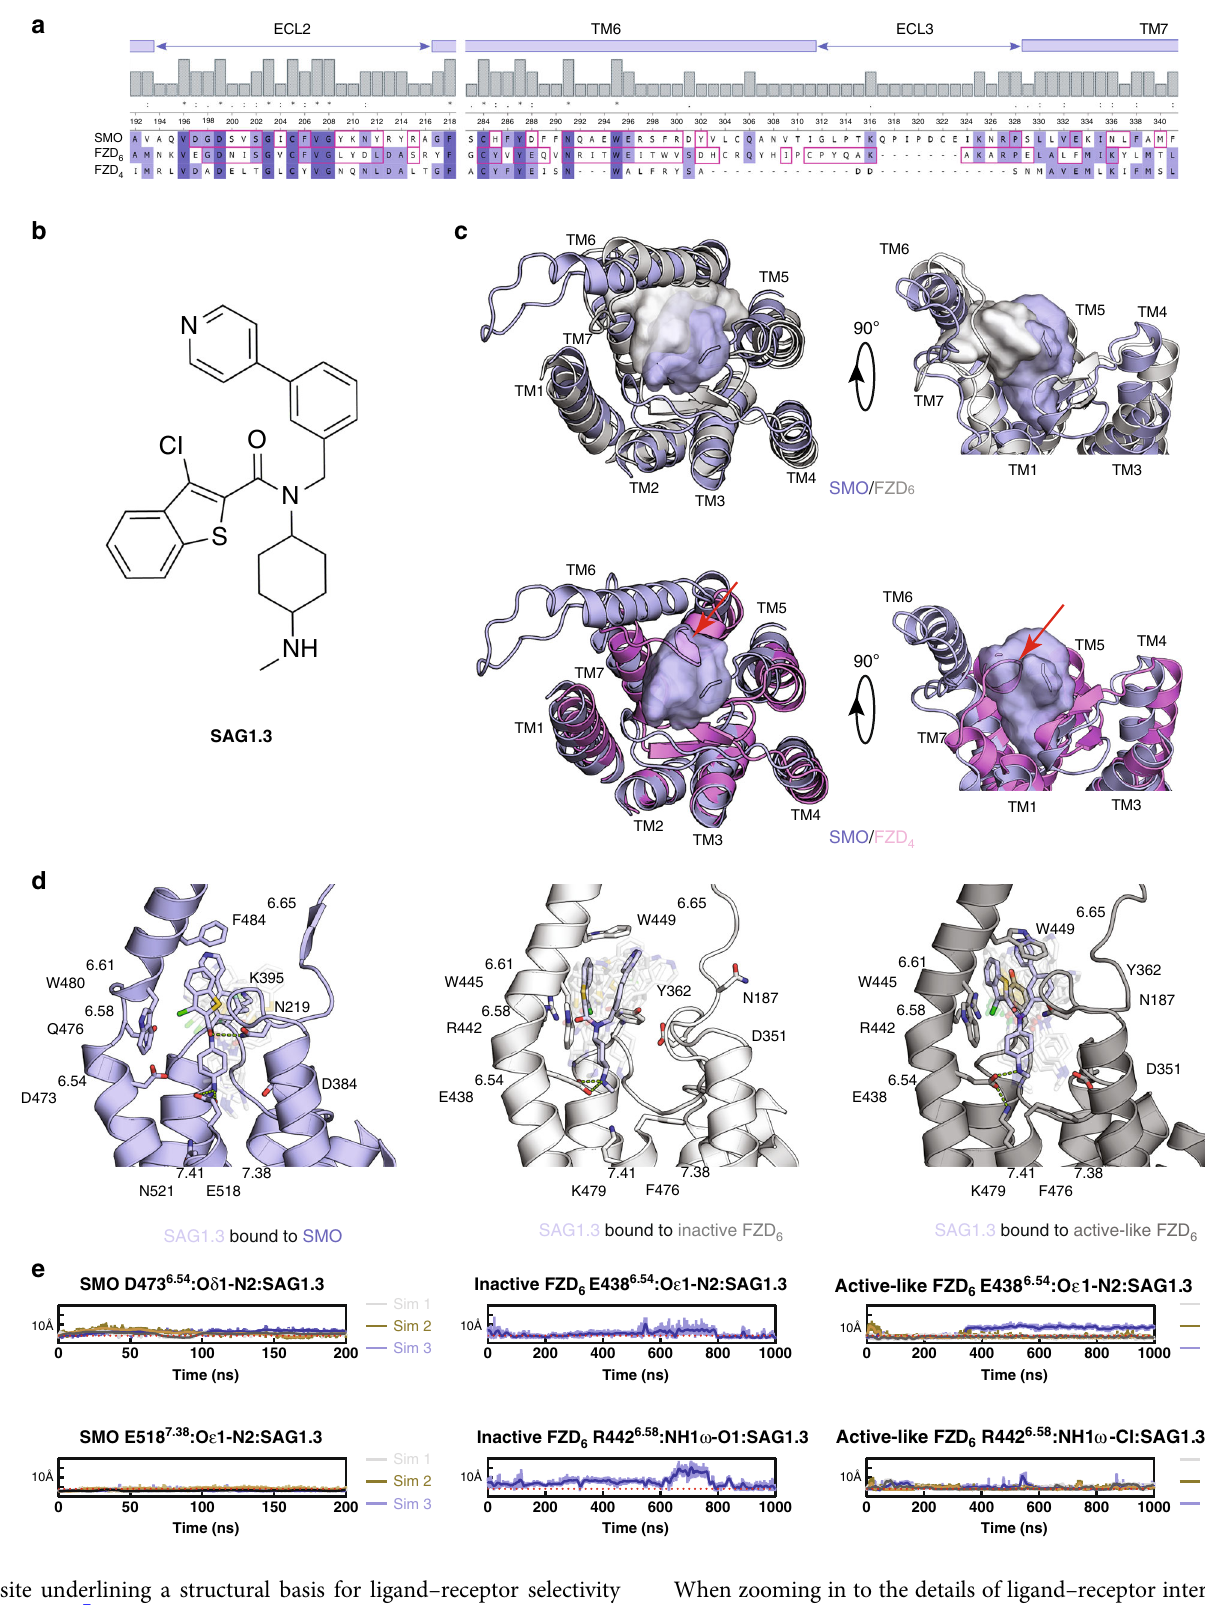
site underlining a structural basis for ligand – receptor selectivity (Fig. 1c) 7 . Sequence alignment of these receptors supports this observation, since the parts of TM6 and ECL3 that construct the binding site of SAG1.3 in FZD 6 and SMO are for the most part missing from the sequence of FZD 4 (Fig. 1a, Supplementary Fig. 1).